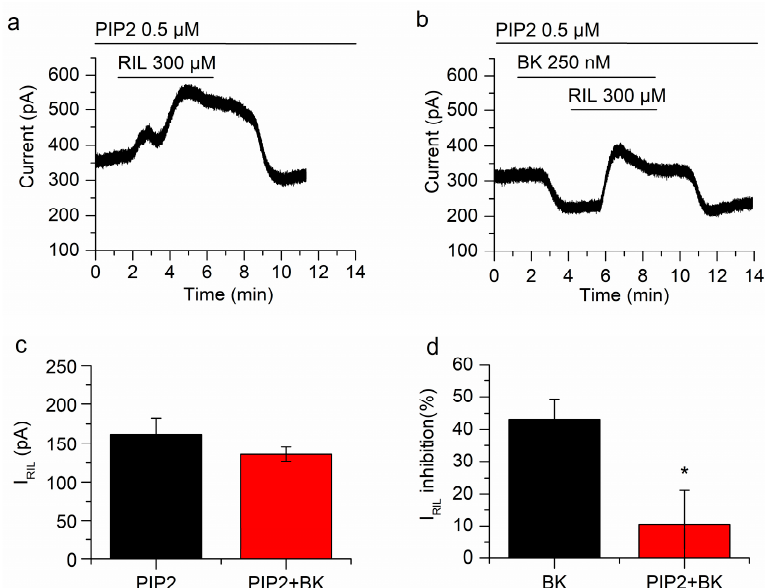
Figure 5. Keeping phosphatidylinositol 4,5-biphosphate (PIP 2 ) concentration precludes the inhibition of TREK-2 by BK. ( a ) Riluzole-activated current after incubation of neurons with diC 8 PIP 2 for 1 h. ( b ) In the presence of a PIP 2 excess, BK clearly reduced I -30 but the inhibition of I RIL by BK was abolished. ( c ) There was no di ff erence between I RIL (black bar; n = 5) and I RIL in the presence of BK (red bar; n = 5) when cells were pre-incubated with diC 8 PIP 2 . ( d ) The inhibition of I RIL by BK in the presence of diC 8 PIP 2 (red bar; n = 5) is significantly di ff erent ( p < 0.05) from the inhibition by BK alone (black bar; n = 7). Recordings in ( a , b ) belong to the same neuron. * p < 0.05.